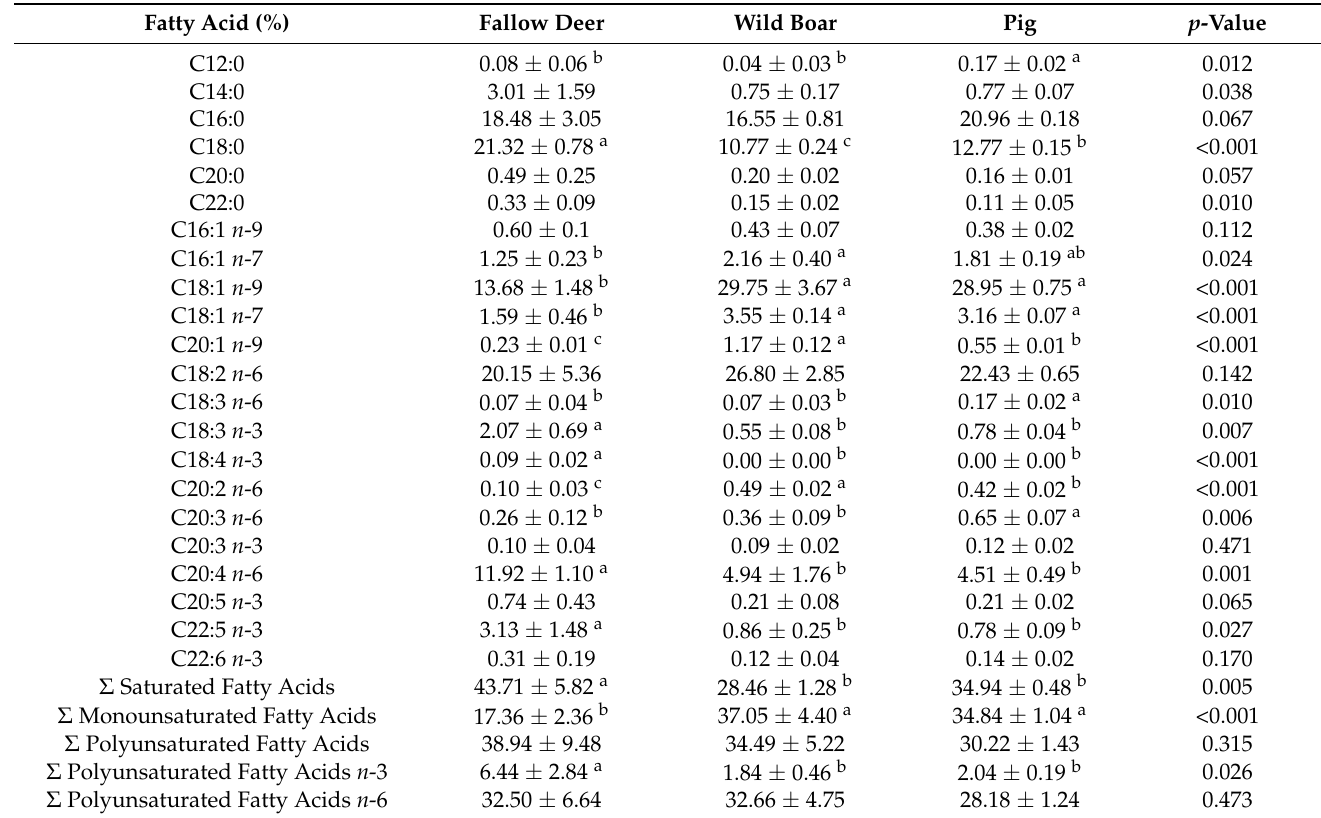
Table 2. The composition of fatty acids of the loin samples (%/total fatty acid; mean ±